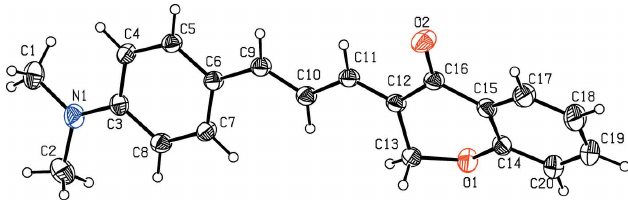
Figure 1 The molecular structure of the title compound, with displacement ellipsoids drawn at the 30% probability level. H atoms are shown as small circles of arbitrary